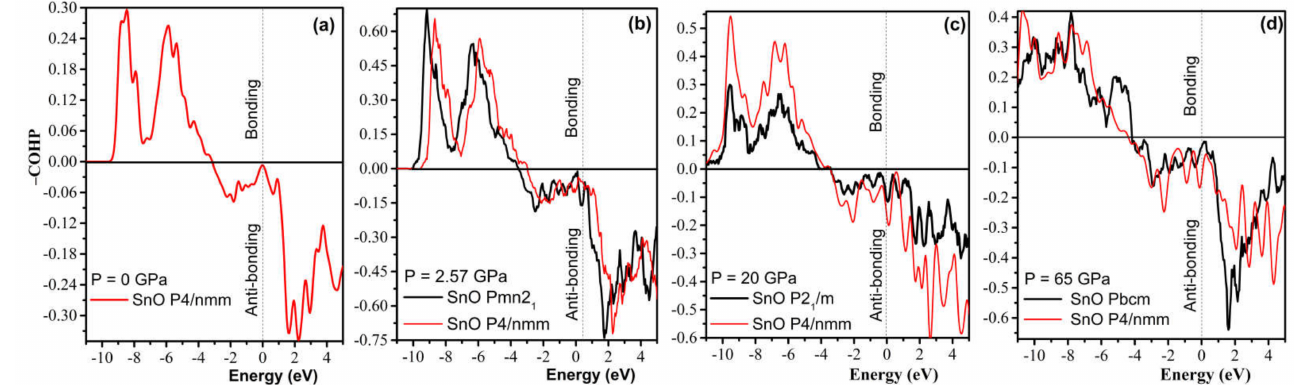
Figure 14. Calculated − COHP diagram of the high-pressure polymorphs of SnO compared to the reference tetragonal P4/nmm at different pressures. Positive energy values of − COHP bonding illustrate the bonding regions, whereas negative energy values describe the antibonding regions: ( a ) P4/nmm ; ( b ) Pmn2 1 vs. P4/nmm ; ( c ) P2 1 /m vs. P4/nmm ; ( d ) Pbcm vs. P4/nmm